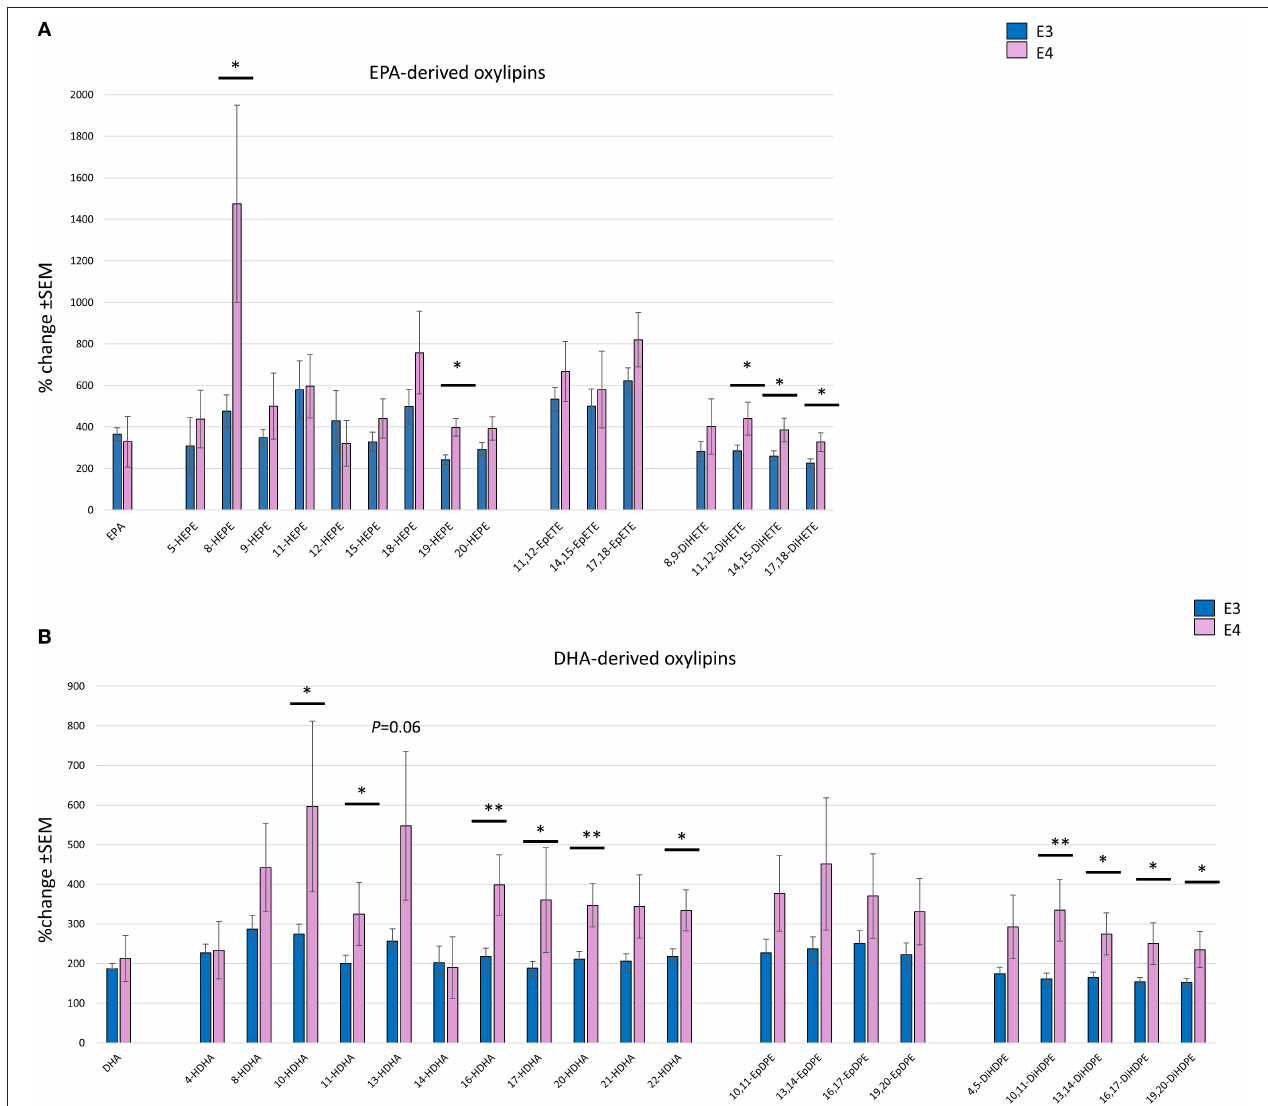
FIGURE 4 | Bar charts showing the mean % change (with SEM) in individual EPA- (A) and DHA- (B) derived oxylipins, with their parent EPA and DHA following 12 months of supplementation with the equivalent of 4 portions of oily fish, comparing between APOE3 ( n = 17) and APOE4 ( n = 5/6). Independent sample t -test or Mann-Witney test was used to compare between APOE genotypes. *Statistically significant, P < 0.05, **Statistically significant, P <